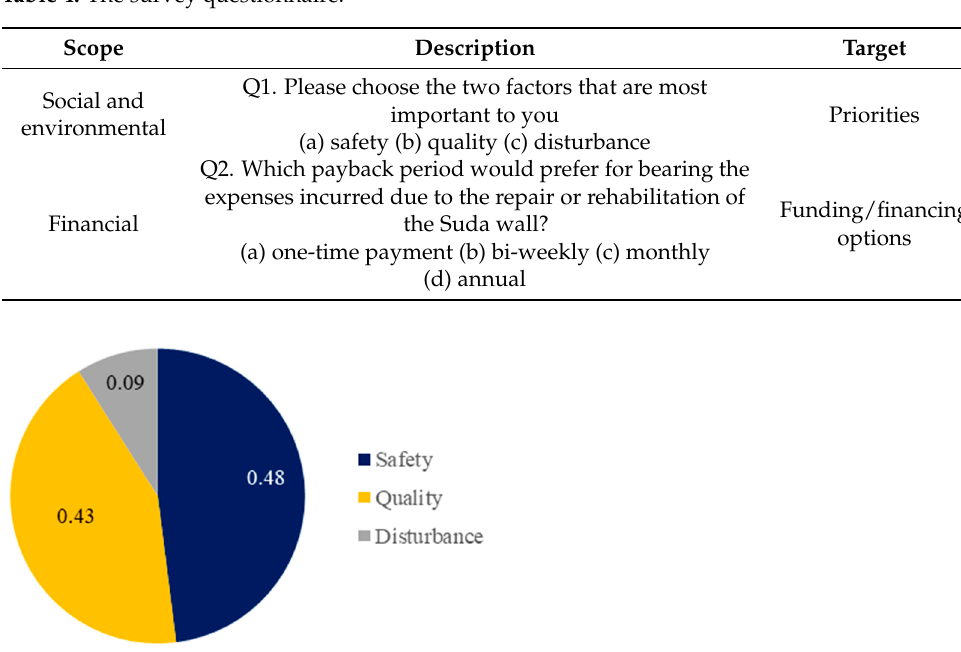
Table 4. The survey questionnaire.